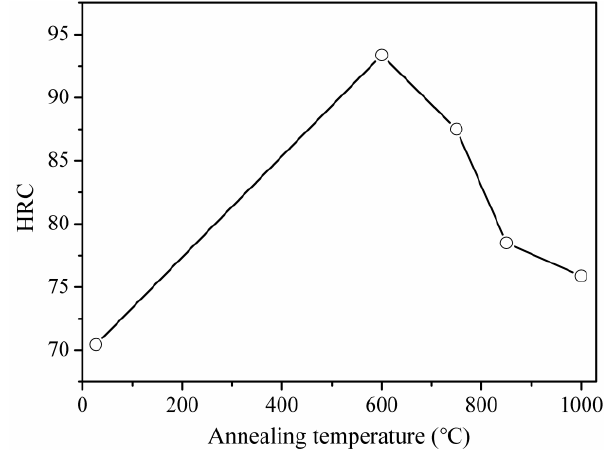
Figure 7. Microstructure of FeNiCoCr HEA samples annealed at different temperatures: ( a ) Initial,